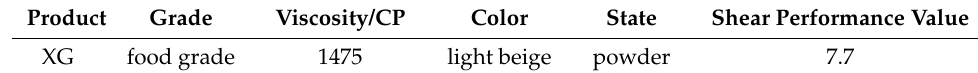
Table 2. Basic physical properties of xanthan gum.